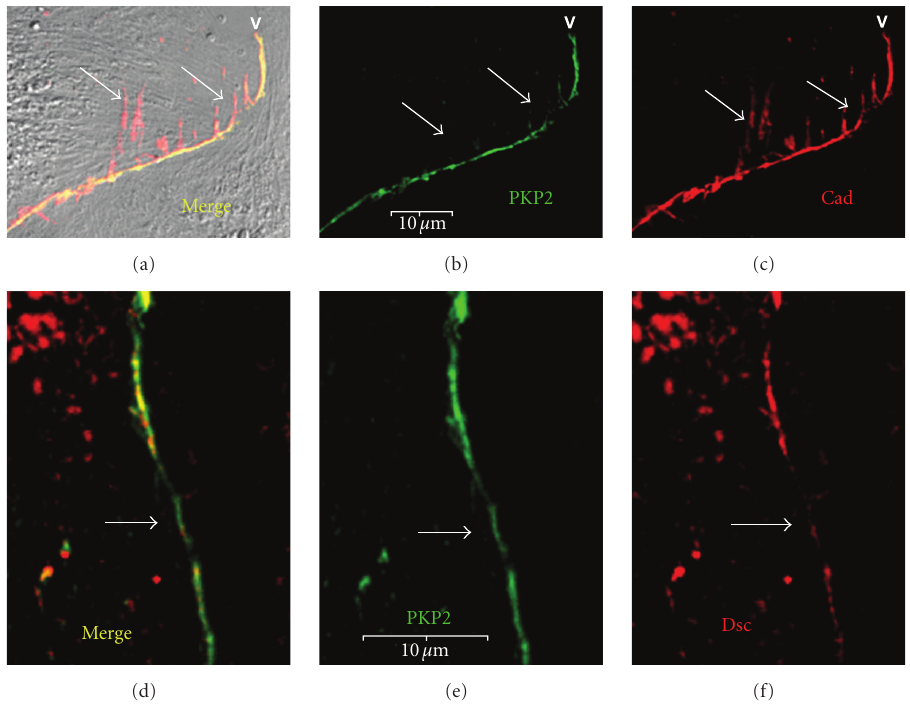
Figure 4: Co-localization of PKP2 with N-cadherin and desmocollin in newly formed cell-cell contacts. ARCs were immunolabeled with antibodies to PKP2 (green: a, b, d, e) and pan-cadherin (red: a, c) or desmocollin (red: d, f) on day 5 post plating. There is an extensive overlap in localization of PKP2 with both N-cadherin and desmocollin. Note that there was a localization of N-cadherin along the lateral aspects of cellular projections at the cell-contact sites (arrows in (a)–(c)). These may represent filopodial extensions that mature into cell- adhesion domains. There was also noted to be some regional variation in the relative amounts of PKP2 and desmocollin (arrows in (d)–(f)). Scale bars are 10 μ